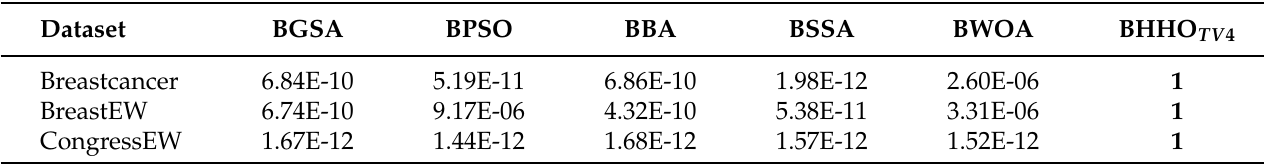
Table 12. The 2-tailed p -values of the Wilcoxon signed ranks test for fitness results reported in Table 11 ( p -values ≤ 0.05 are